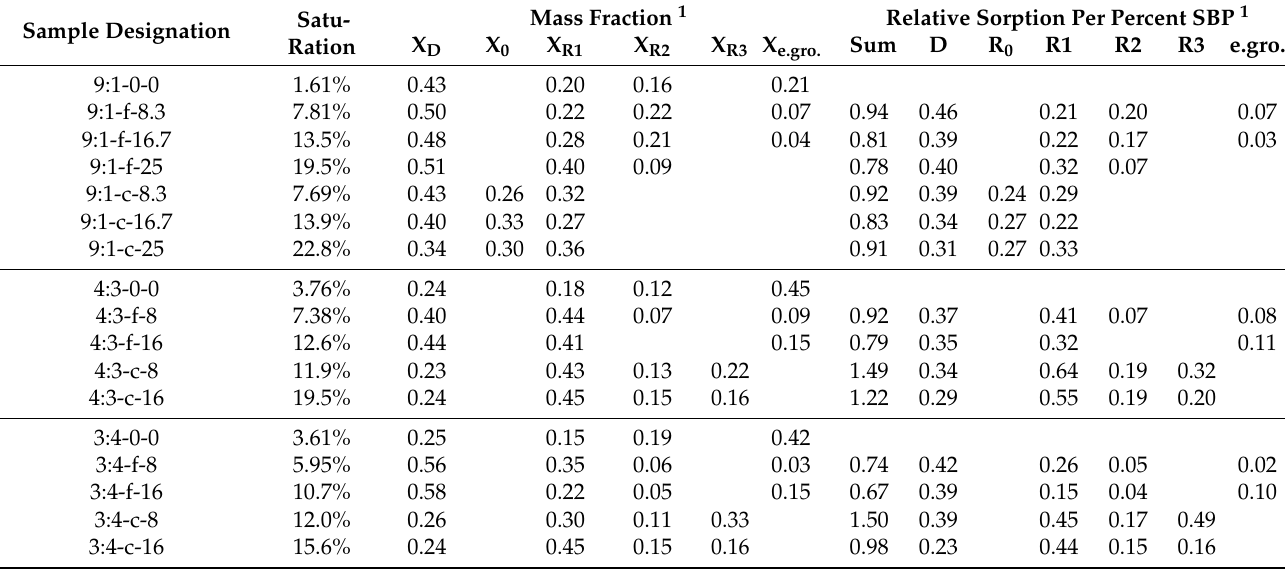
Table 4. Water sorption parameters from simulation of PLA–PBS–SBP